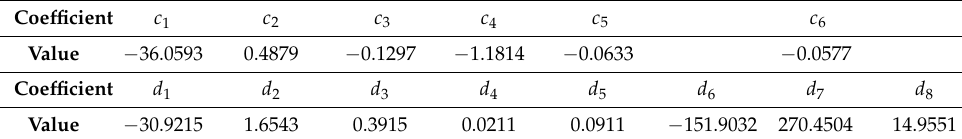
Table 6. The coefficients in Equation (16).